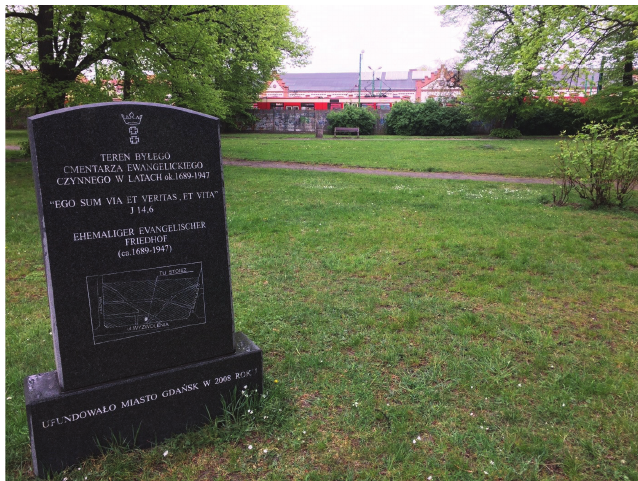
Figure 18. Gravestone commemorating the former cemetery in Nowy Port (turned into a public park and a tram depot). Photo: K.